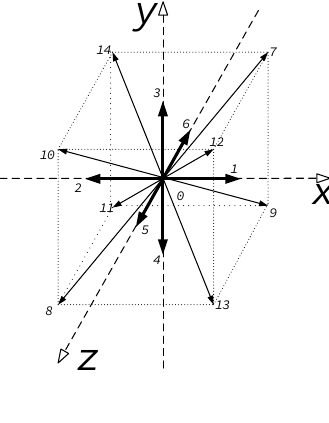
Fig. 1. Direction